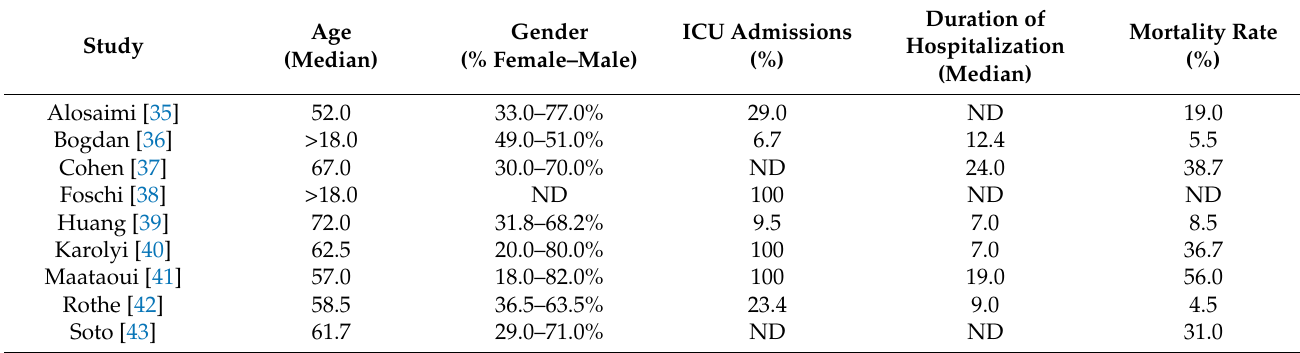
Table 2. Demographic data and clinical